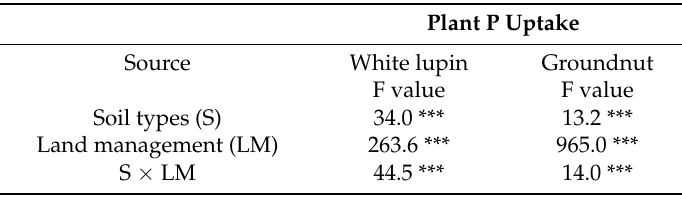
Table 3. Summary of two-way analysis of variance for the effect of soil types (S) and land management (LM) on plant P uptake of white lupin and groundnut.